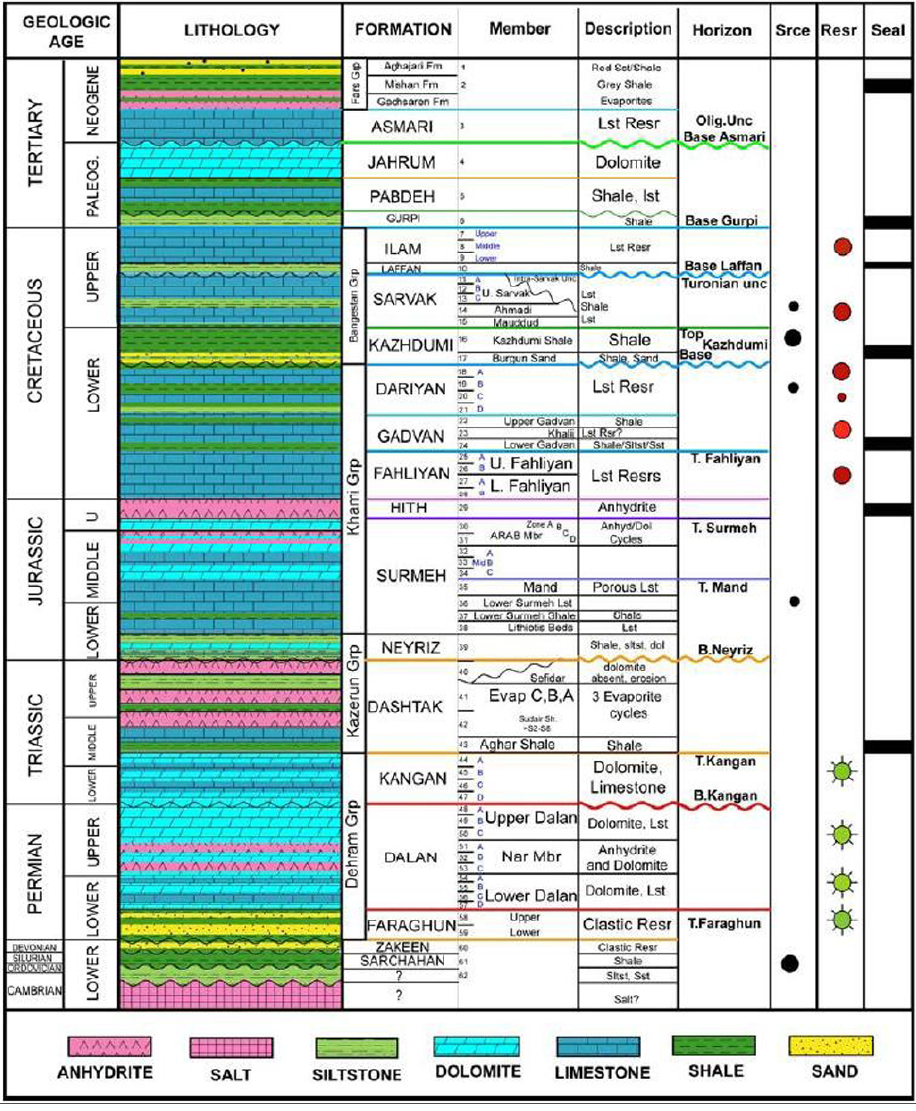
Fig. 2. General stratigraphic column in the Persian Gulf (Ghazban,